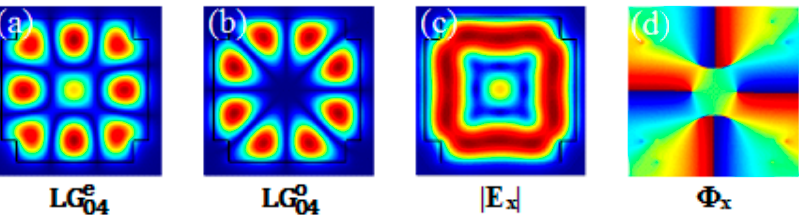
Figure 6. HG-similar component mode field distributions in the designed waveguide for l = ±4 OAM mode: ( a ) LG (cid:2868)(cid:2872)(cid:3032) and ;( b ) LG (cid:2868)(cid:2872)(cid:3042) modes. Field (Ex, horizontal component) and phase distributions of the resulting OAM mode: ( c ) electric field and ( d ) phase distributions.